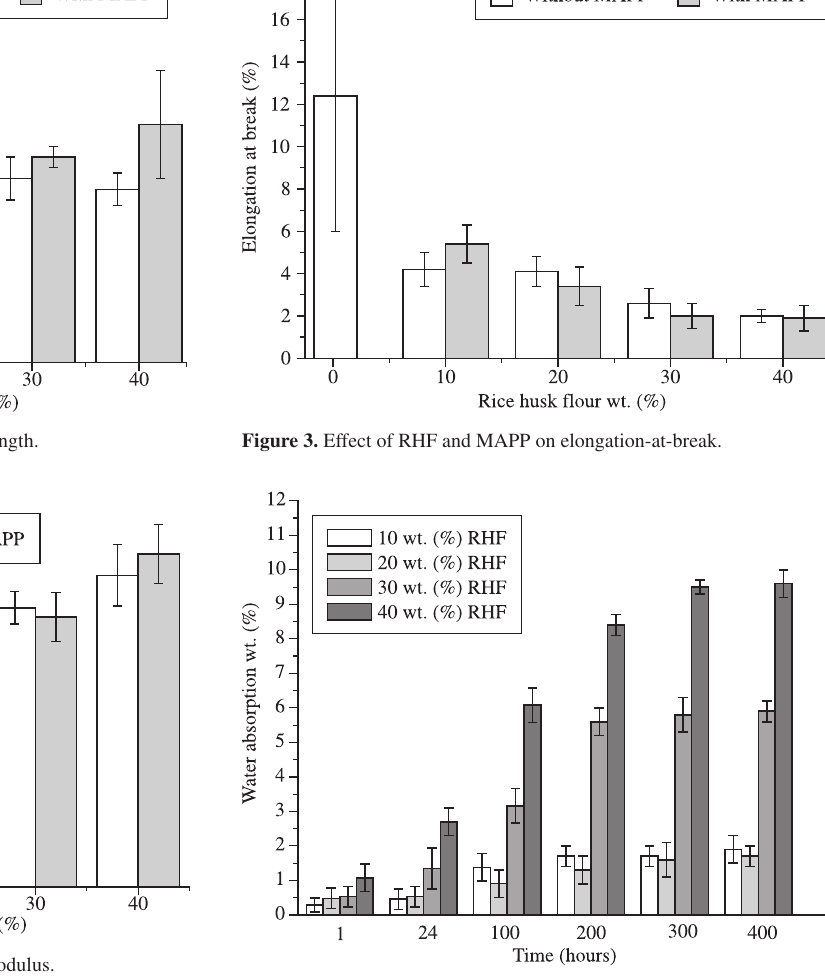
Figure 4. Water absorption at different RHF